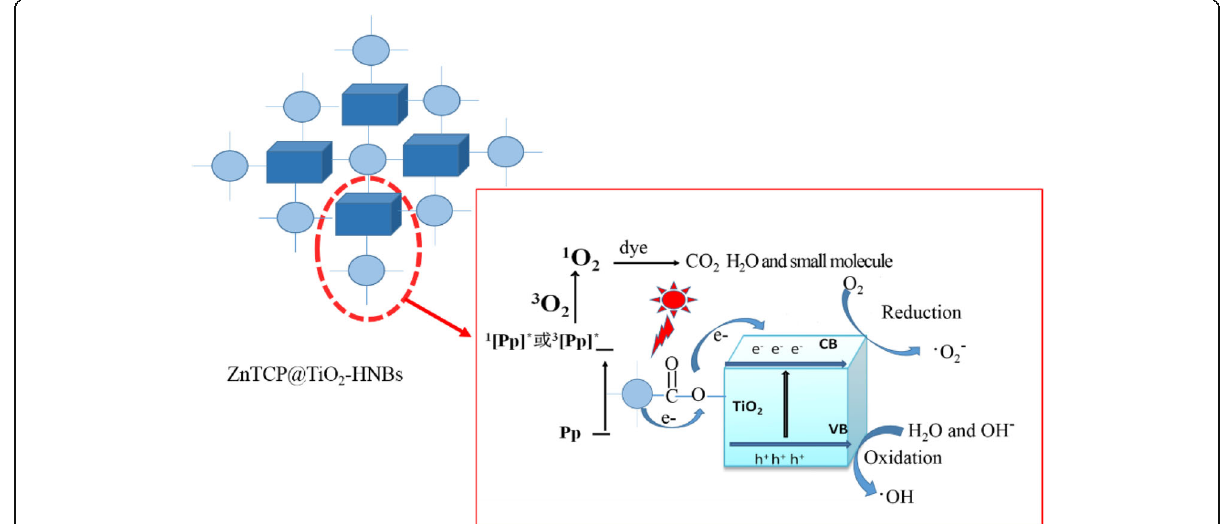
Fig. 12 Proposed probable photocatalytic mechanism of ZnTCP@TiO 2